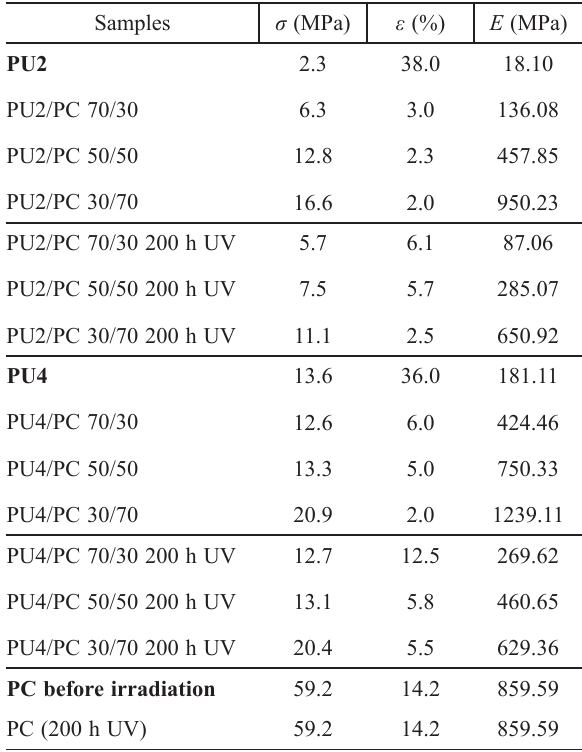
Table 5 – Mechanical properties before and after uV irradi - ation